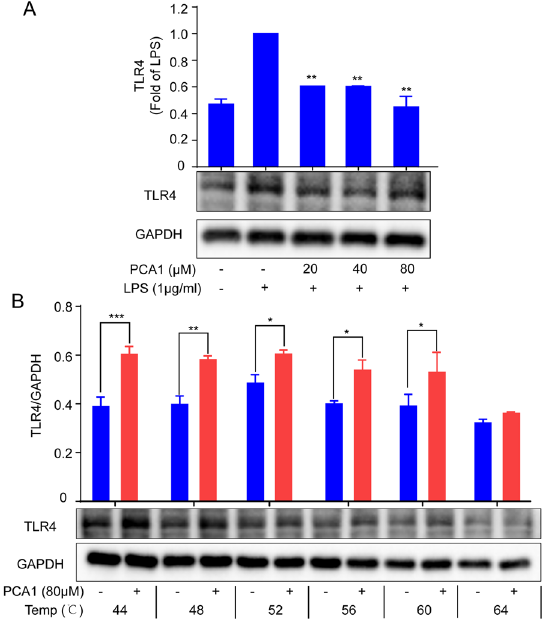
Figure 8. PCA1 binds to TLR4. ( A ) RAW264.7 cells treated with for PCA1 (0, 20, 40, 80 μ M) for 2 h were incubated with LPS for 2 h. The expression of TLR4 were detected using Western blotting. ( B ) Treated with PCA1 (80 μ M) for 2 h, cells were lysed by RIPA and total proteins were collected. Then, proteins were equally divided into 6 parts, which were heated at 44, 48, 52, 56, 60, and 64 °C for 3 min, respectively. The corresponding loading buffer were added into the proteins, which were analysed by western blotting. The grouping of gels/ blots cropped from different parts of the same gel (targets vs loading control). The full blots are shown in Supplementary Information. * p < 0.05, ** p < 0.01, and *** p < 0.001 versus the LPS-induced/compared